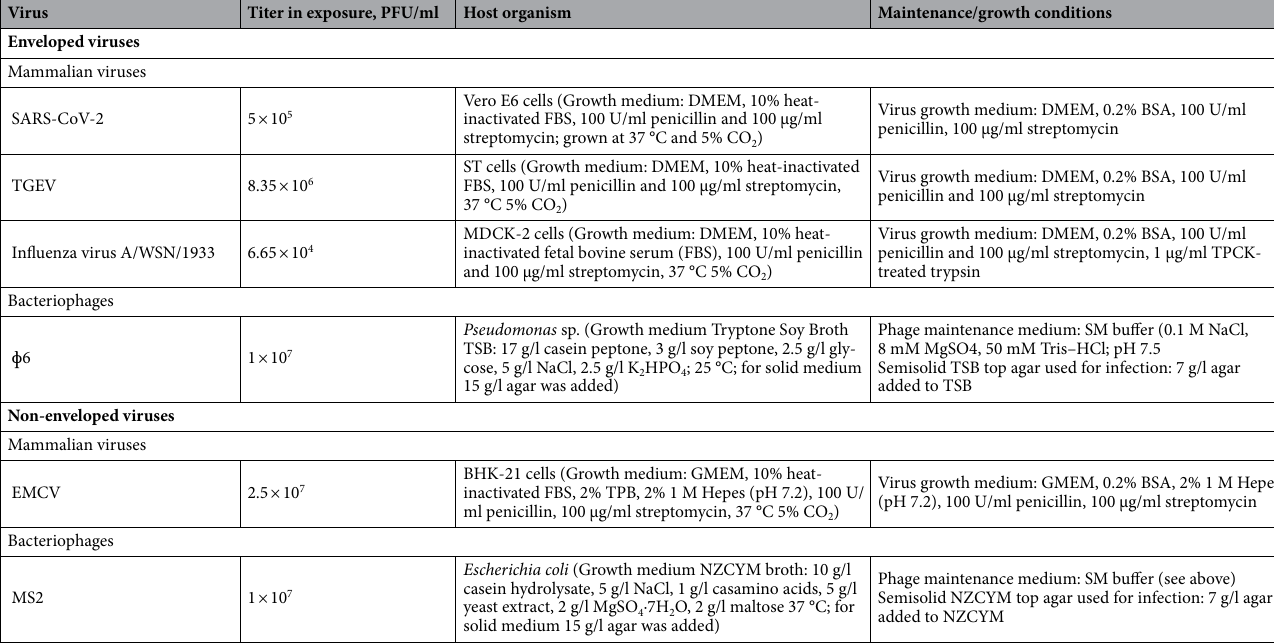
Table 4. Viruses, their host organisms and maintenance